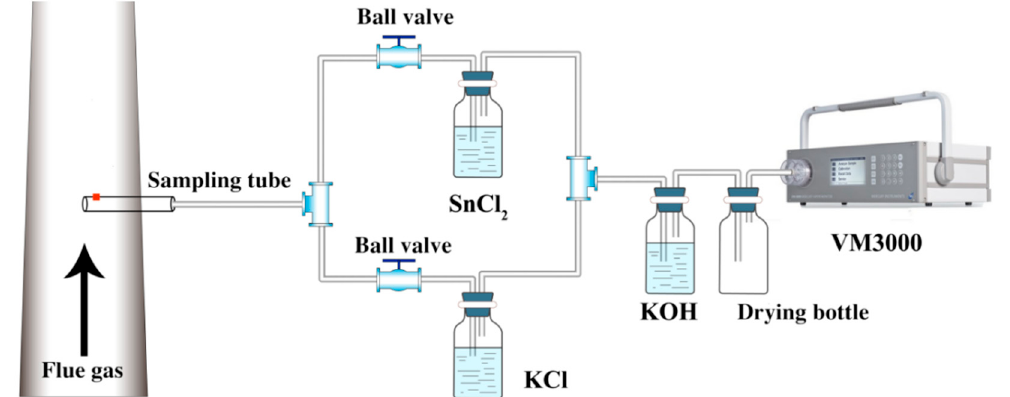
Figure 2. Hg sampling measurement device.